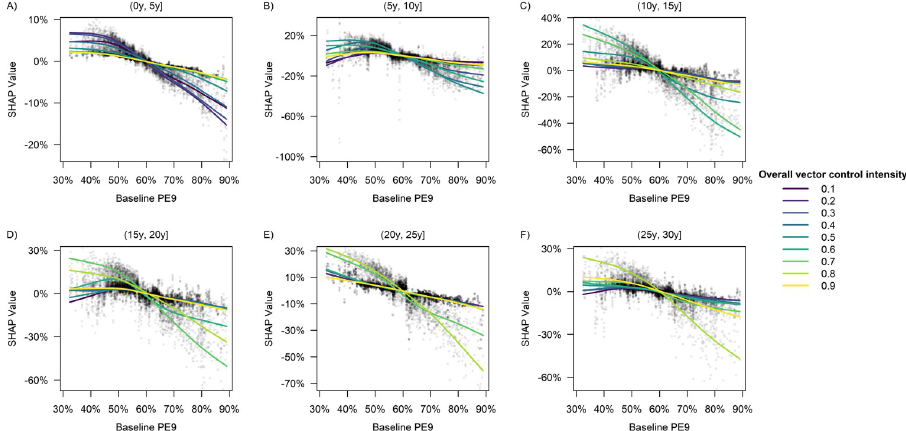
Fig 7. Impact of baseline PE9 on the predicted vector control effectiveness within each of the following time windows : (A) (0y, 5y], (B) (5y, 10y], (C) (10y, 15y], (D) (15y, 20y], (E) (20y, 25y], (F) (25y, 30y]. The baseline PE9 referred to the proportion of nine-year olds who had prior dengue exposure at the end of the warm-up period. Each point represents a single simulation run, and the SHAP value quantified the change in the predicted vector control effectiveness due to the value of baseline PE9. Each curve was obtained by fitting a smoothing spline to the set of data points corresponding to a given overall level of vector control intensity.